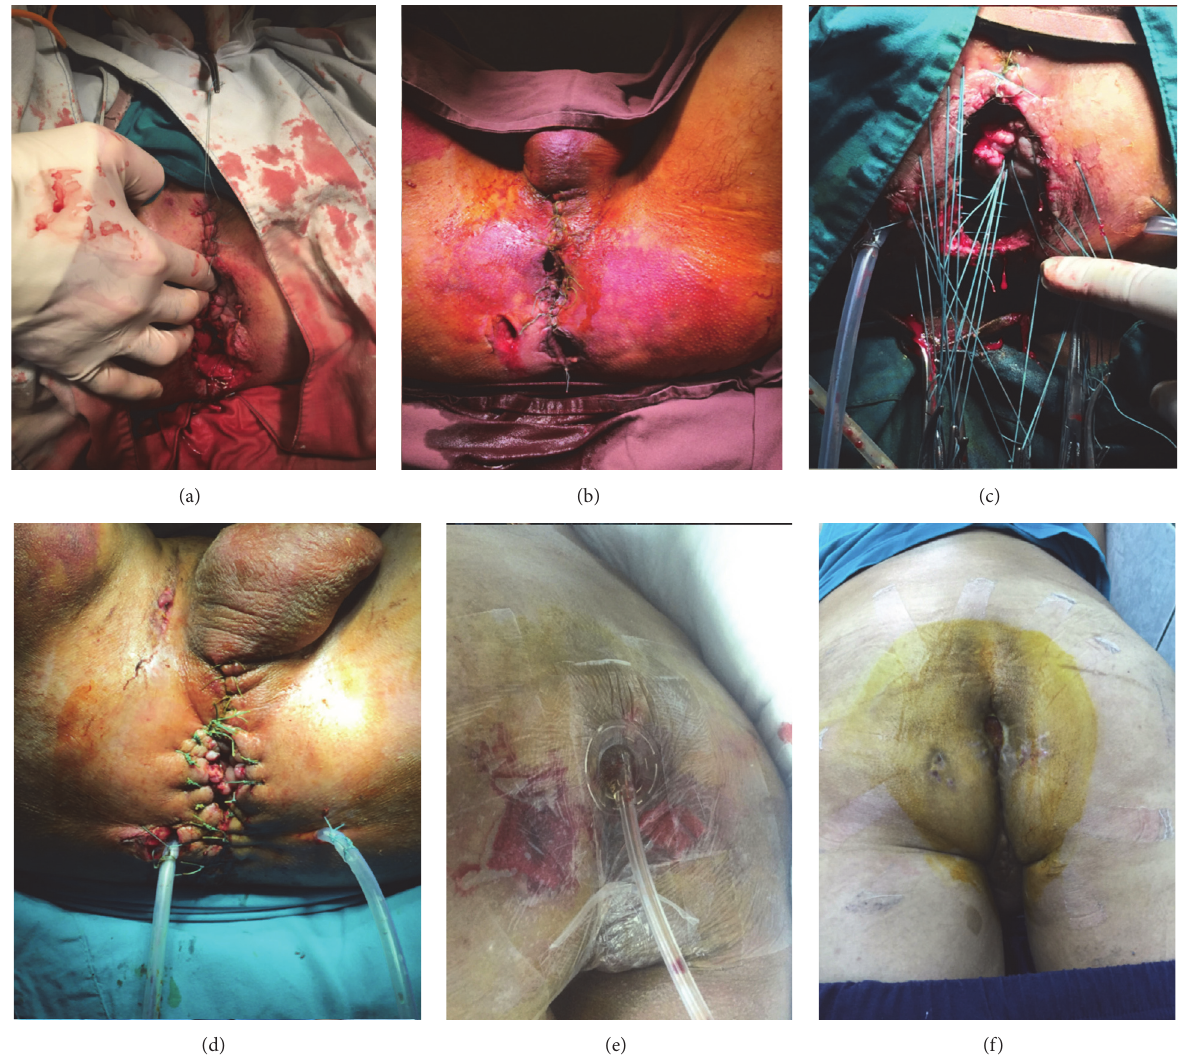
Figure 2: Illustration of the perineal wound. (a) On first surgical procedure in our center; (b) 48 hours later before packs removal; (c) and (d) 48 hours later, after packs removal, lavage, reinsertion of the anorectum, and large drainage of the pelvic space; (e) negative wound pressure therapy of the perineal wound; (f) healed perineal wound on